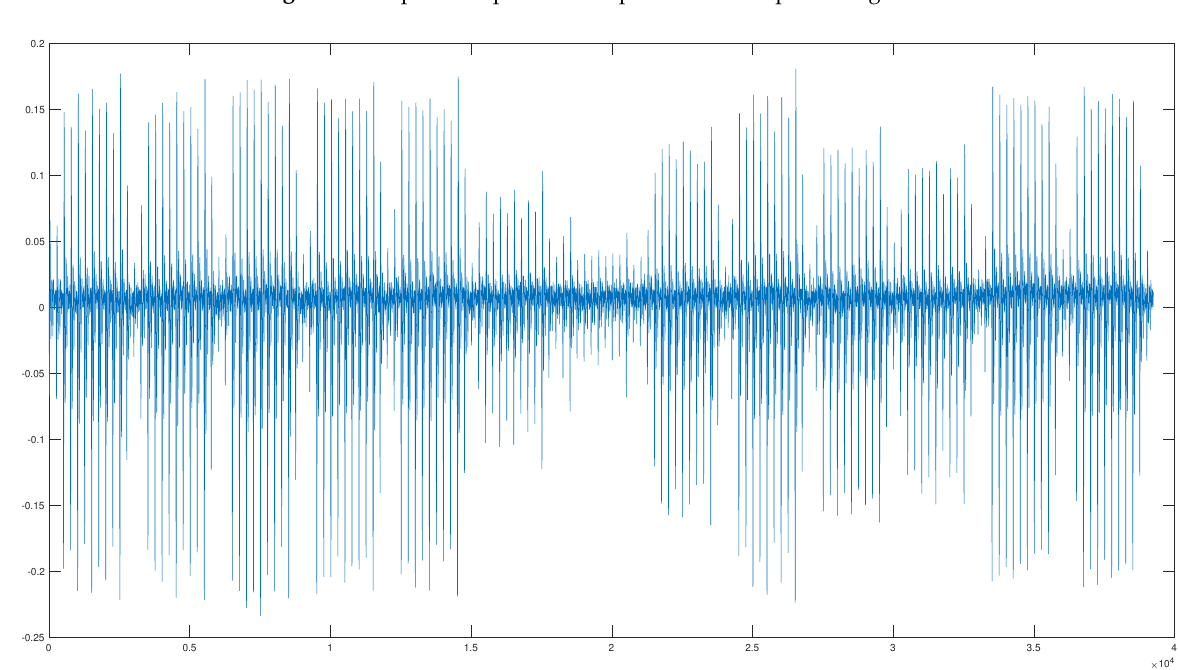
Figure 5. Sample of Protected implementation representing bit